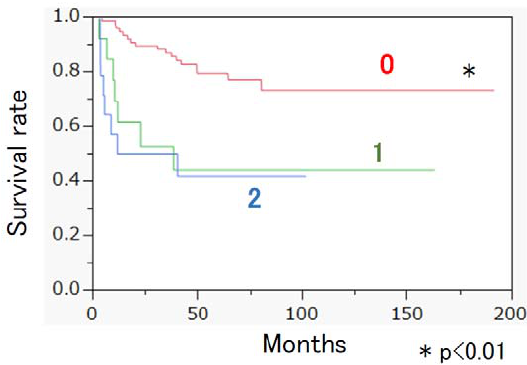
Figure 1. Kaplan–Meier survival analysis of each Glasgow prognostic score (GPS) group; Kaplan–Meier survival analysis showed that the GPS 0 group showed significantly longer median survival time than did the GPS 1 and GPS 2